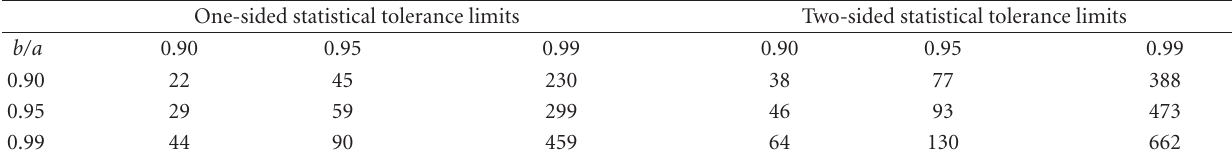
Table 1: Minimum number of calculations n for one-sided and two-sided statistical tolerance